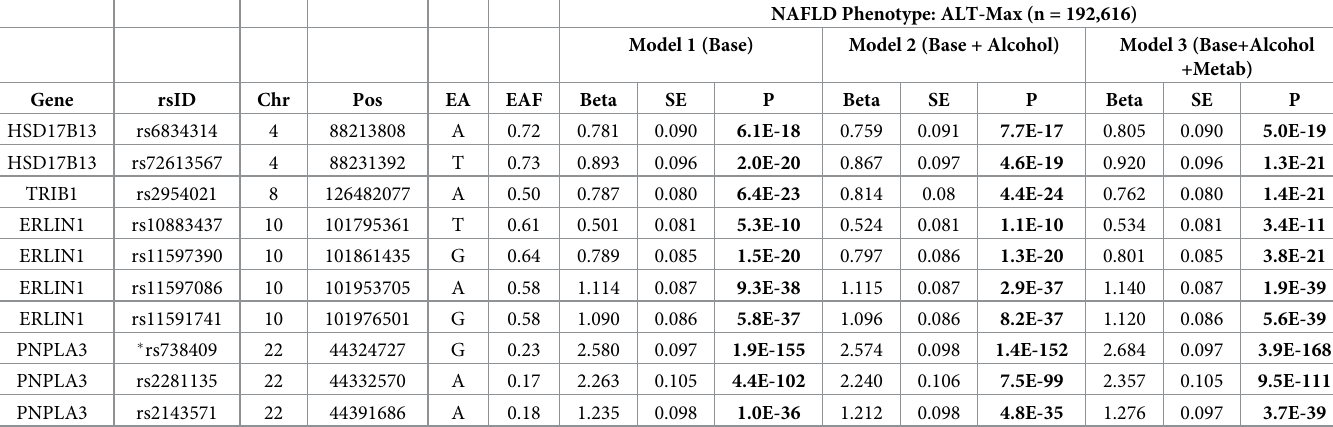
Table 3. Previously published ALT-associated variants with genome-wide significance and association with maximal ALT at